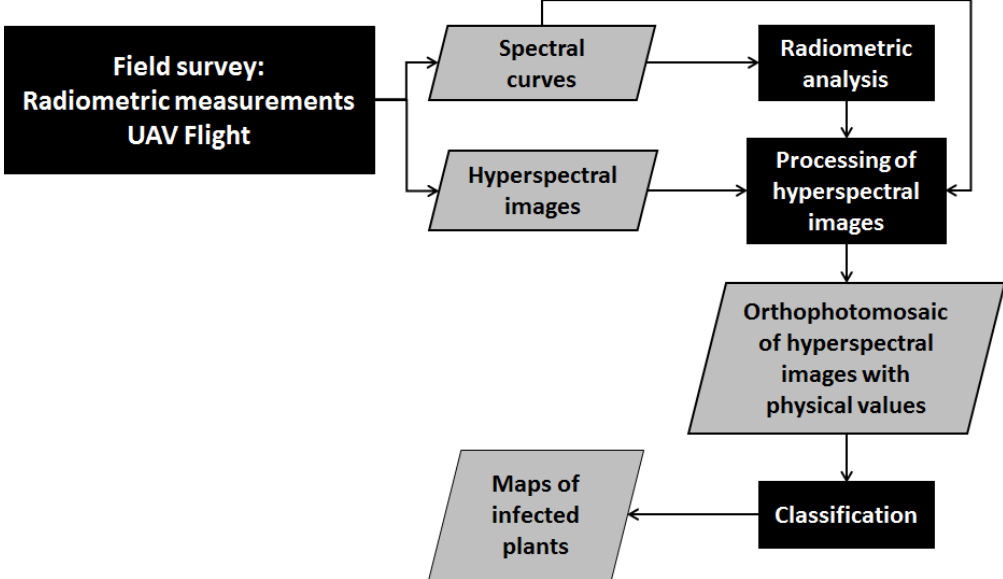
Figure 4. Flowchart of hyperspectral cube